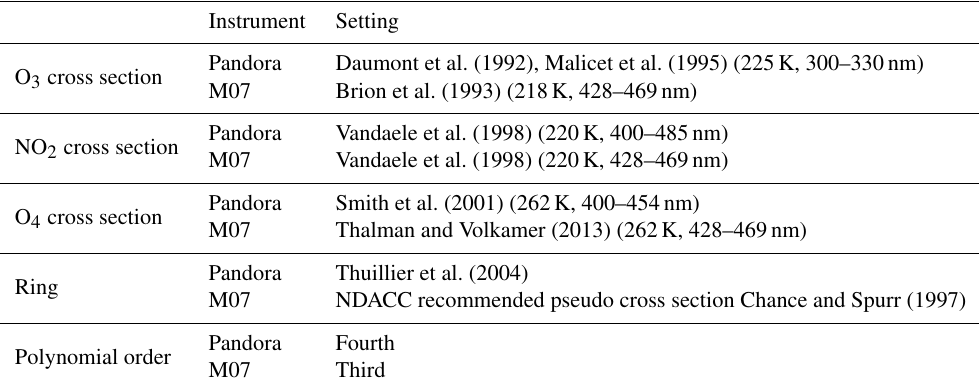
Table 1. Relevant retrieval details for the two instruments under study. Instrument